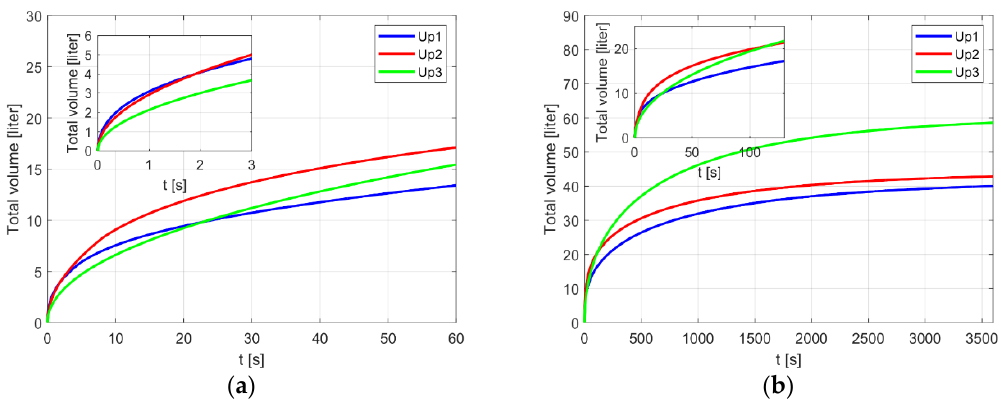
Figure 8. Water uptake [liters] as a function of time [s] for the three cases studied (Table 2). Graphs in the two panels correspond to two time intervals: ( a ) 0–1 min and ( b ) 0–1 h, respectively. Graph colors: the blue, red and green curves denote cases Up1, Up2 and Up3, respectively.